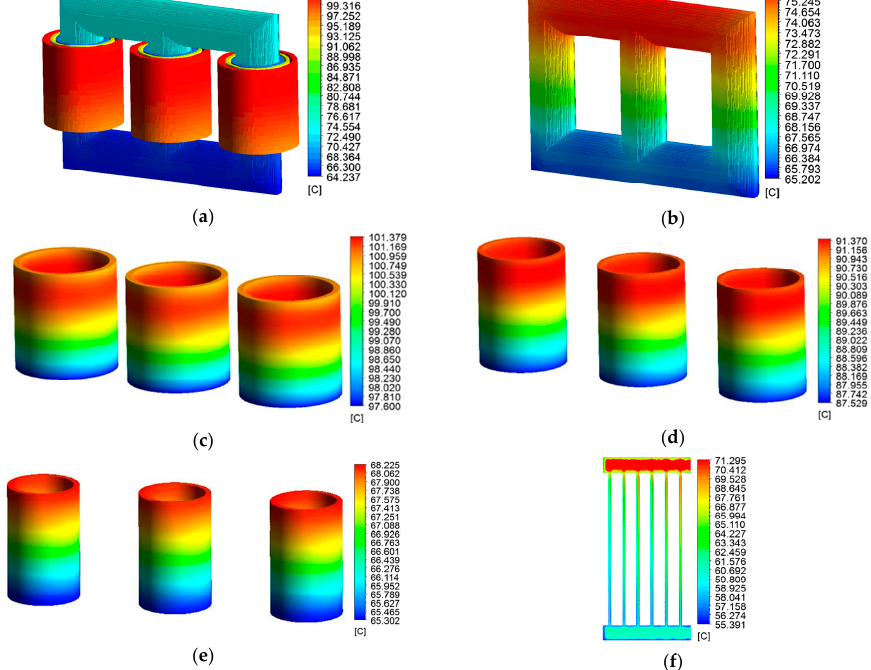
Figure 6. ( a ) Temperature distribution inside transformer (total model); ( b ) Temperature distribution of core; ( c ) Temperature distribution of HV windings; ( d ) Temperature distribution of inner MV windings; ( e ) Temperature distribution of outer LV windings and ( f ) Temperature distribution inside of radiator (section view).